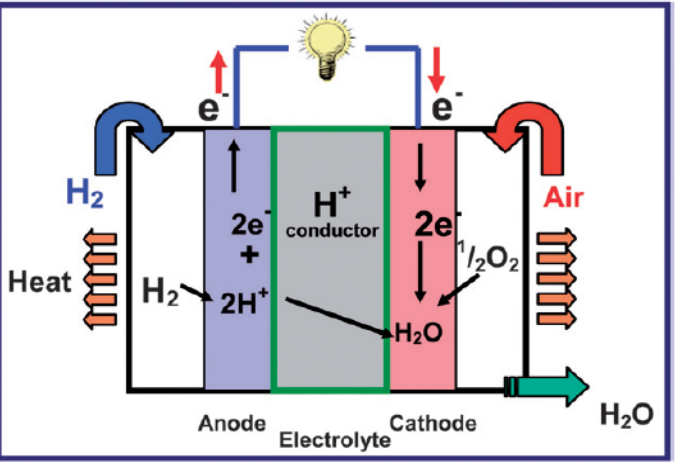
Figure 1. Operating principles of a proton exchange membrane fuel cell